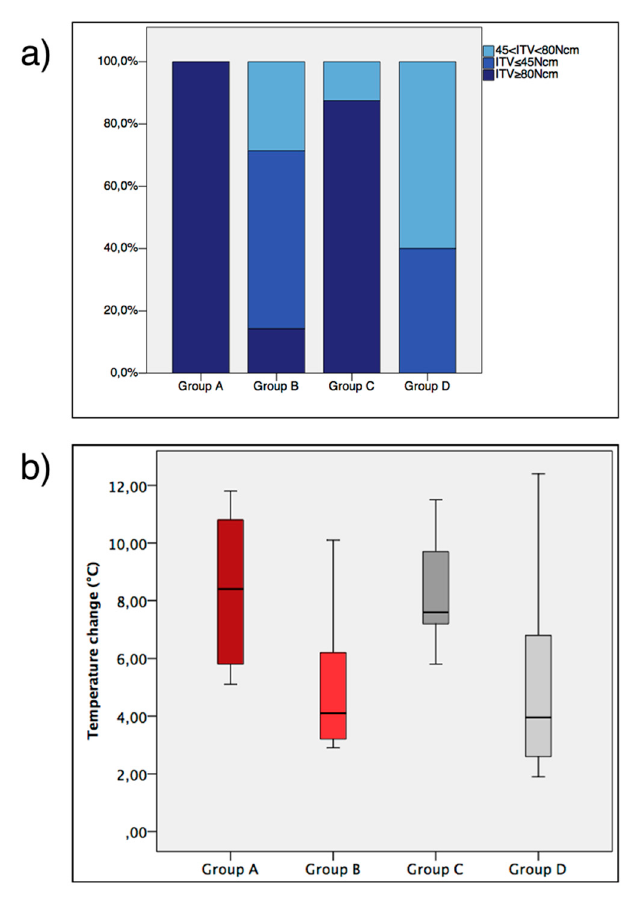
Figure 2. ( a ) Cumulative percentage of insertion torque value (ITV) classes divided per group. Note that all implants installed for group A had a ITV ≥ 80 Ncm. ( b ) Temperature change represented in box-plots.